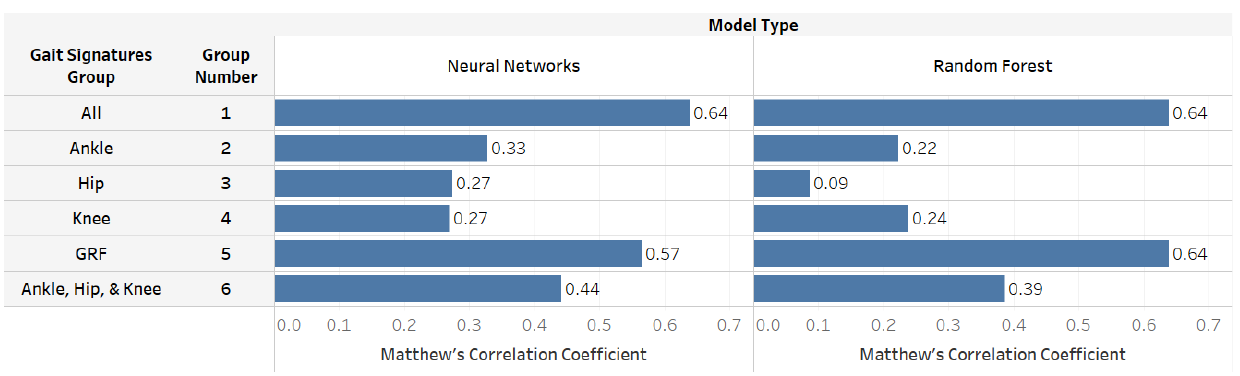
Figure 7. A measurement of the ability of a few laboratory-based gait features to distinguish PAD using Matthew’s Correlation Coefficient. Generally, the GRF-based models (Groups 1 and 5) performed better than joint data models (Groups 2, 3, 4, and 6) and provided comparable results to using all gait features. Table 2. A summary of the models’ performances on the testing data. It evaluates the applied model scores utilizing every group based on four performance metrics. The shaded columns highlight the comparison between all gait features models (Group 1) and GRF features (Group 6).